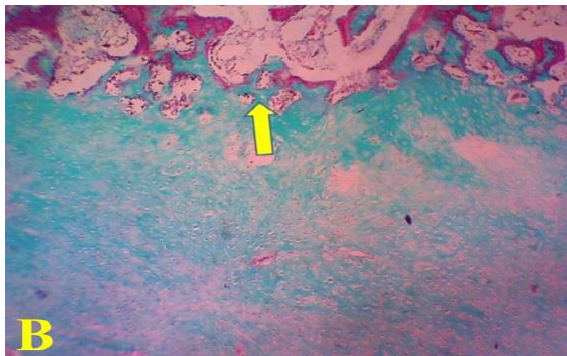
Figure, 5: In the second group at the tenth week, shown a significant proliferation of fibrocartilaginous tissue (green arrow) with ossifications of chondrocytes (yellow arrow) as well as new formation of bone trabeculae. A: H&E X40, B: Masson trichrom X40. In the third group noticed proliferation of cartilaginous tissue and transformed into a new boney tissue, with presence of many new bone trabeculae, (Fig. 6 A and B).